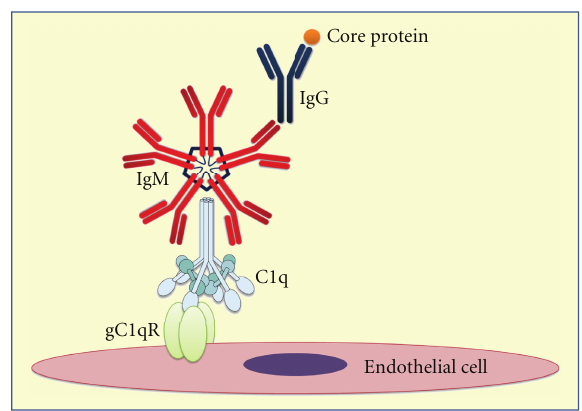
Figure 3: Pathogenetic model of cryoglobulinemic tissue damage. HCV core protein, which has been detected in cryoprecipitate immune complexes, interacts with C1q protein and the receptor for the globular domain of C1q protein (gC1q-R) on the surface of both circulating blood and endothelial cells. Cryoprecipitating immune complexes, including gC1qR complexed to HCV core and C1q proteins, bind in turn IgM molecules with rheumatoid factor activity linked to anti-HCV